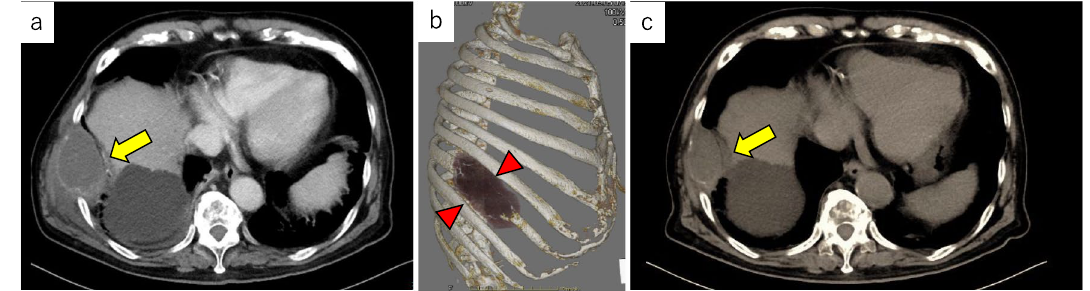
Fig. 1 CT scan images of the chest wall tumor. a Axial CT image at the first visit. b 3D-reconstructed CT image of the tumor. c CT scan image of the tumor with spontaneously regression after 1 month